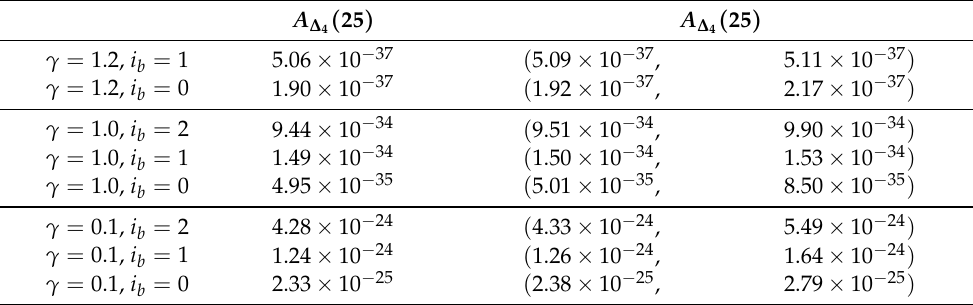
Table 3. Numerical calculation of the amplitude A ∆ spins are all equal j = 1 and the cut-off ∆ l =